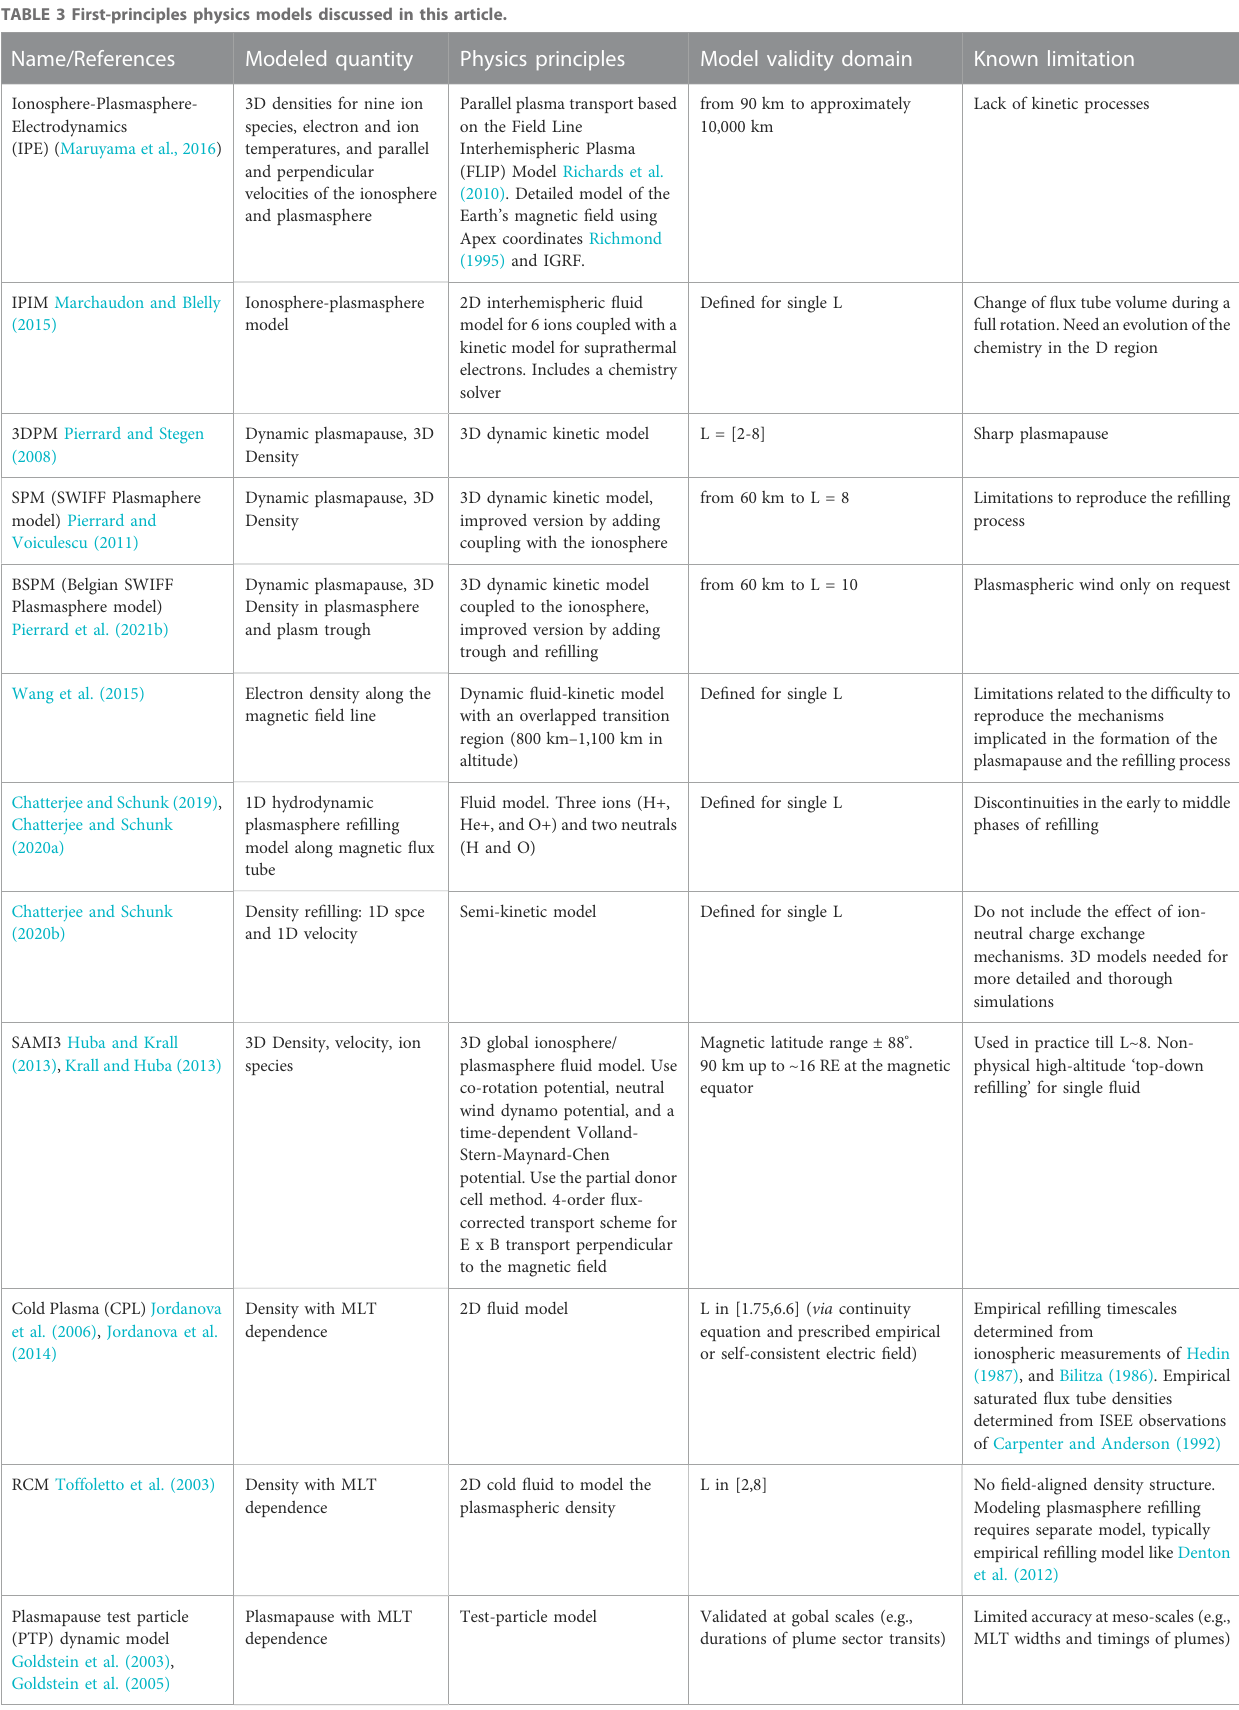
TABLE 3 First-principles physics models discussed in this